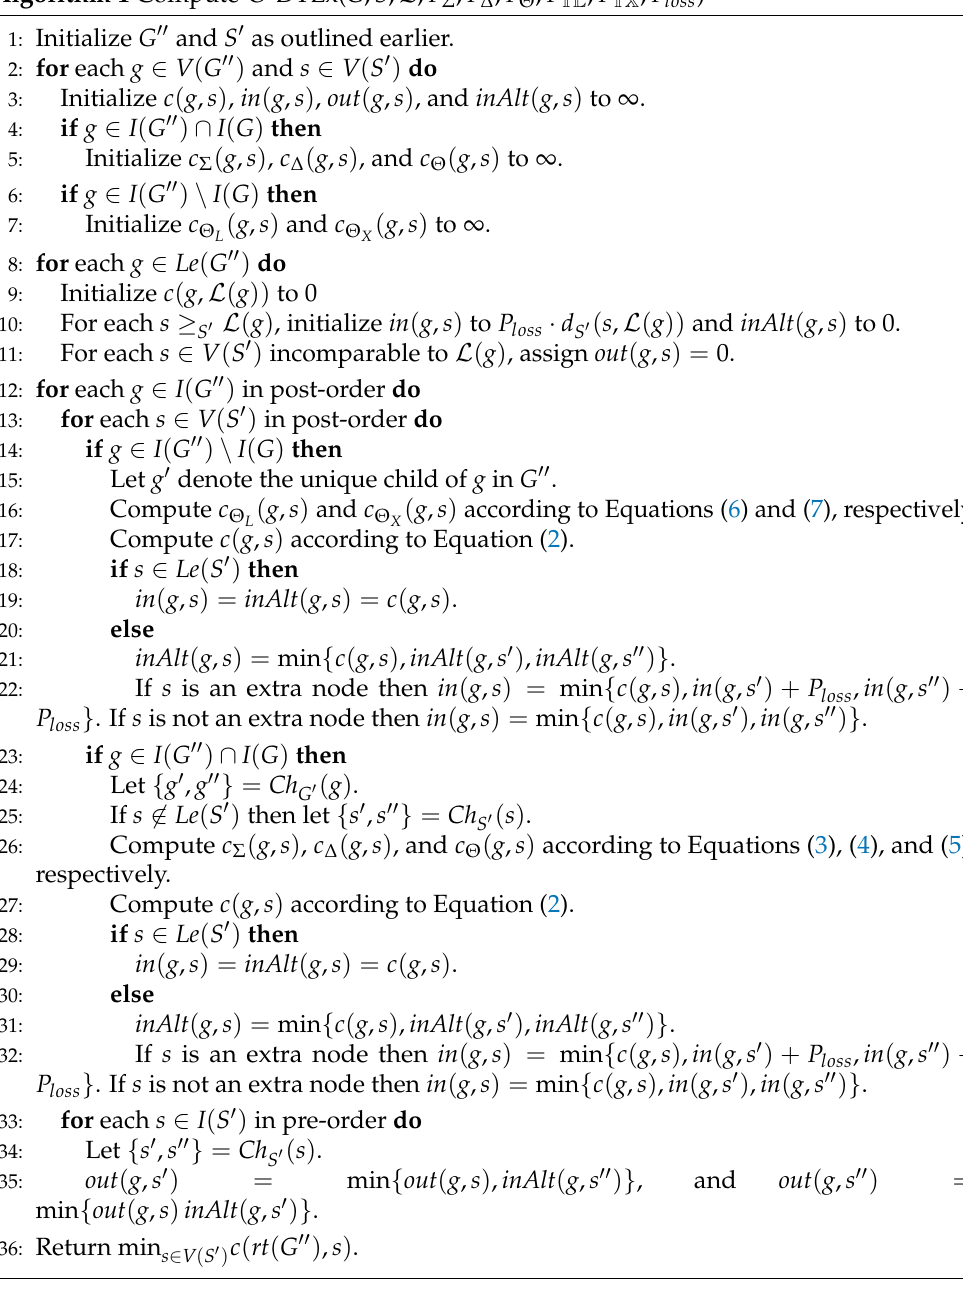
Algorithm 1 Compute-O-DTLx( G , S , L , P Σ , P ∆ , P Θ , P TL , P TX , P loss